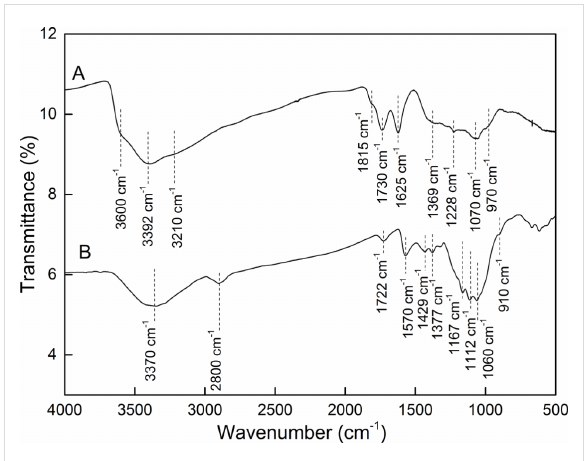
GO-P retained a thin-layer morphology similar to that of GO.